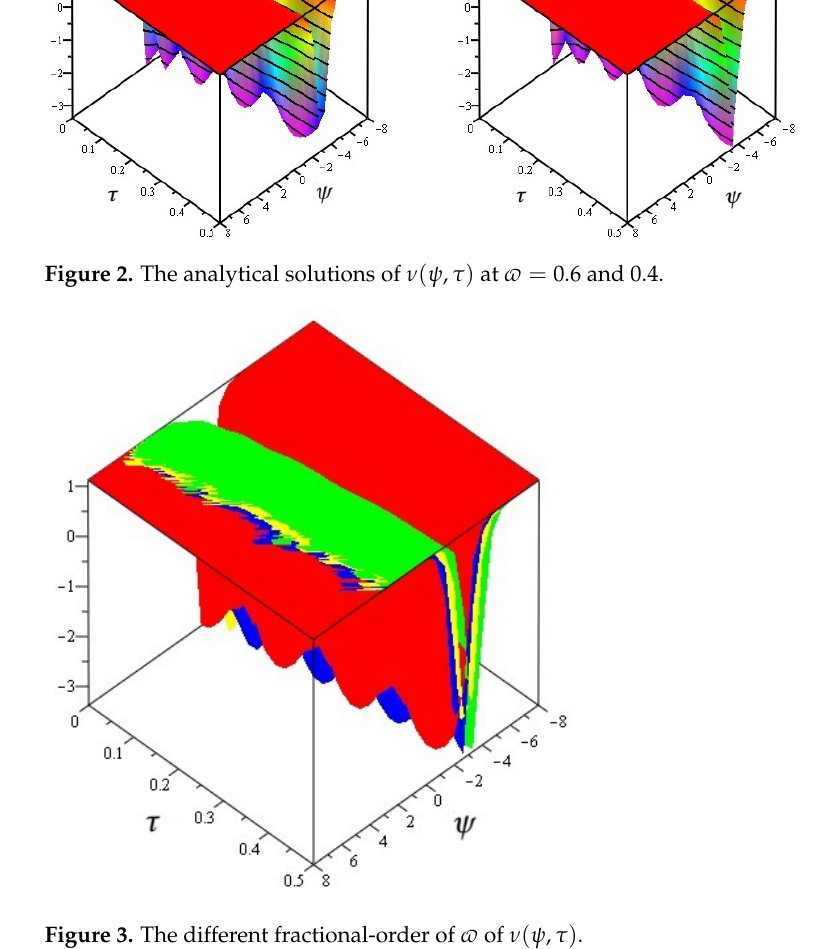
Figure 3. The different fractional-order of (cid:118) of ν ( ψ , τ ) .